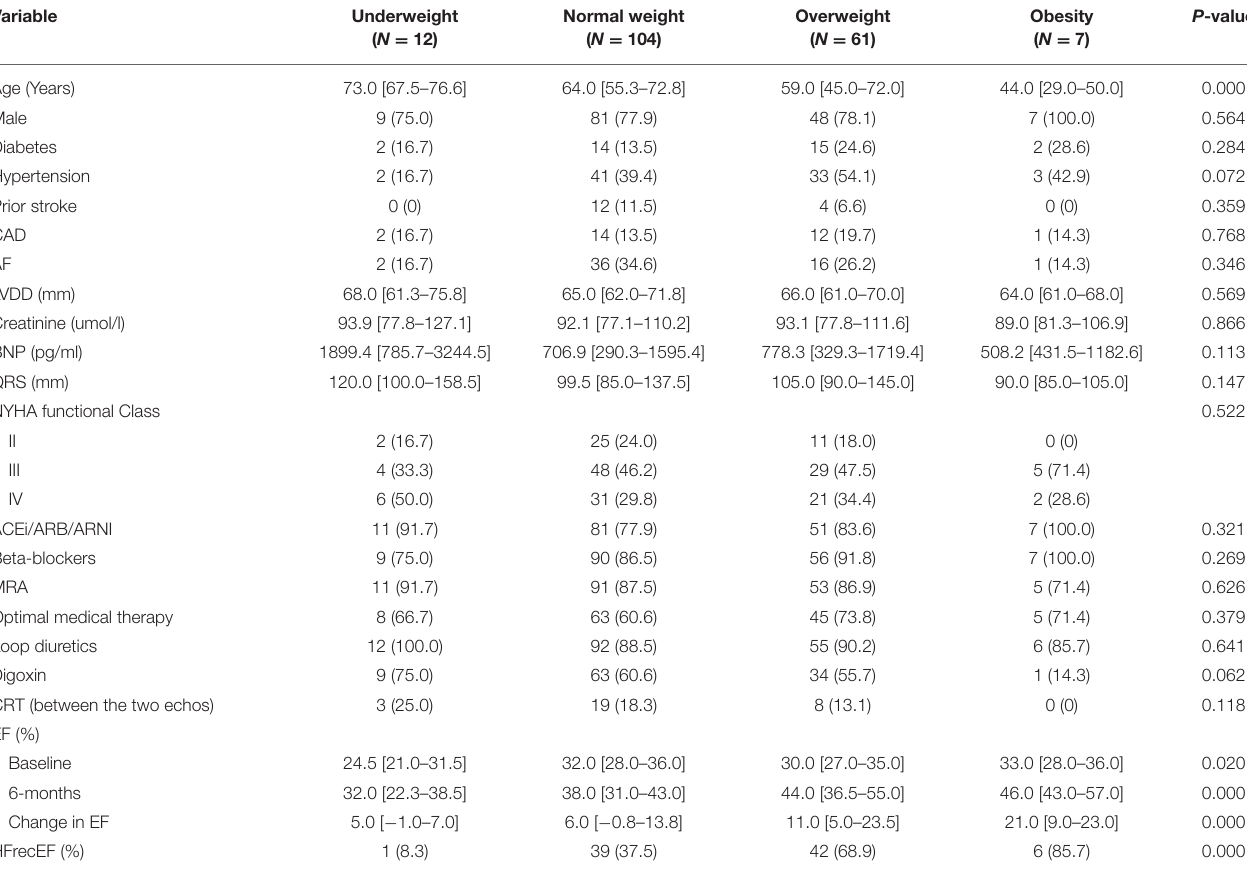
TABLE 1 | Clinical characteristics according to baseline body mass index.